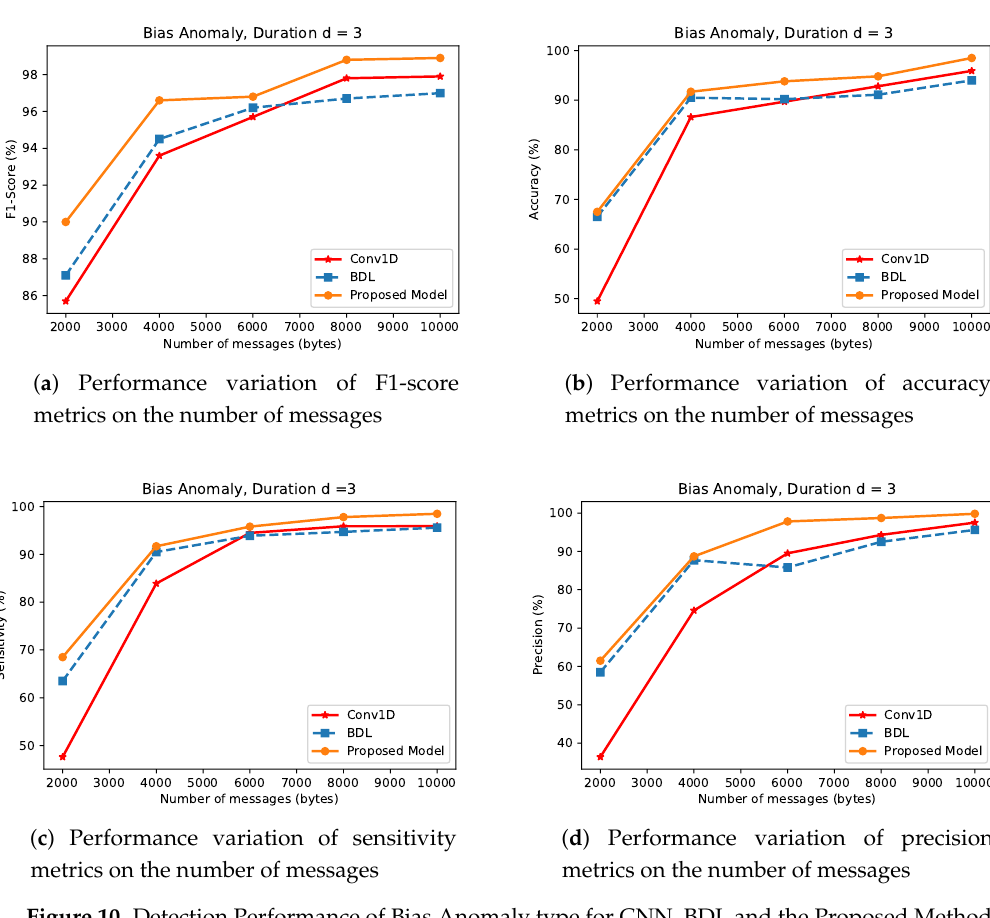
Figure 10. Detection Performance of Bias Anomaly type for CNN, BDL and the Proposed